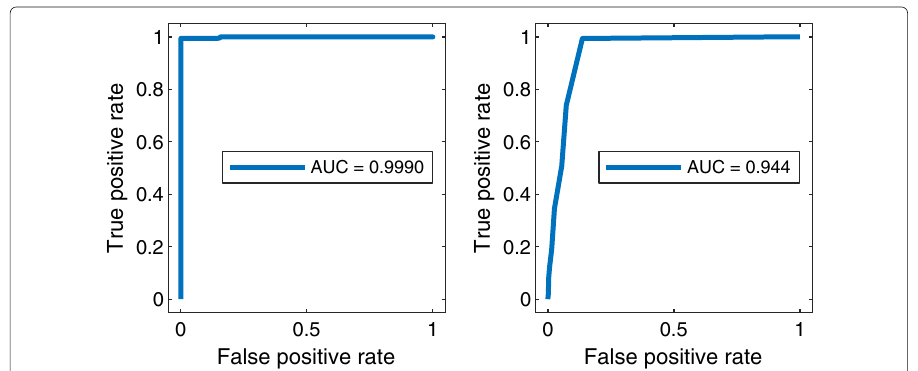
Fig. 3 ROC-plot for semi-supervised anomaly detection (left) and unsupervised anomaly detection (right)